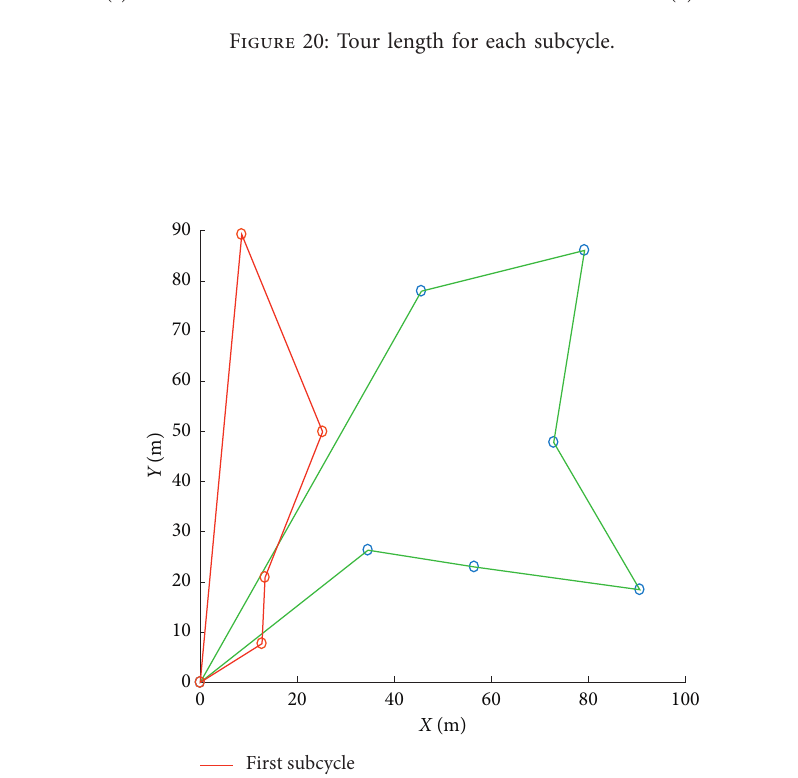
Figure 20: Tour length for each